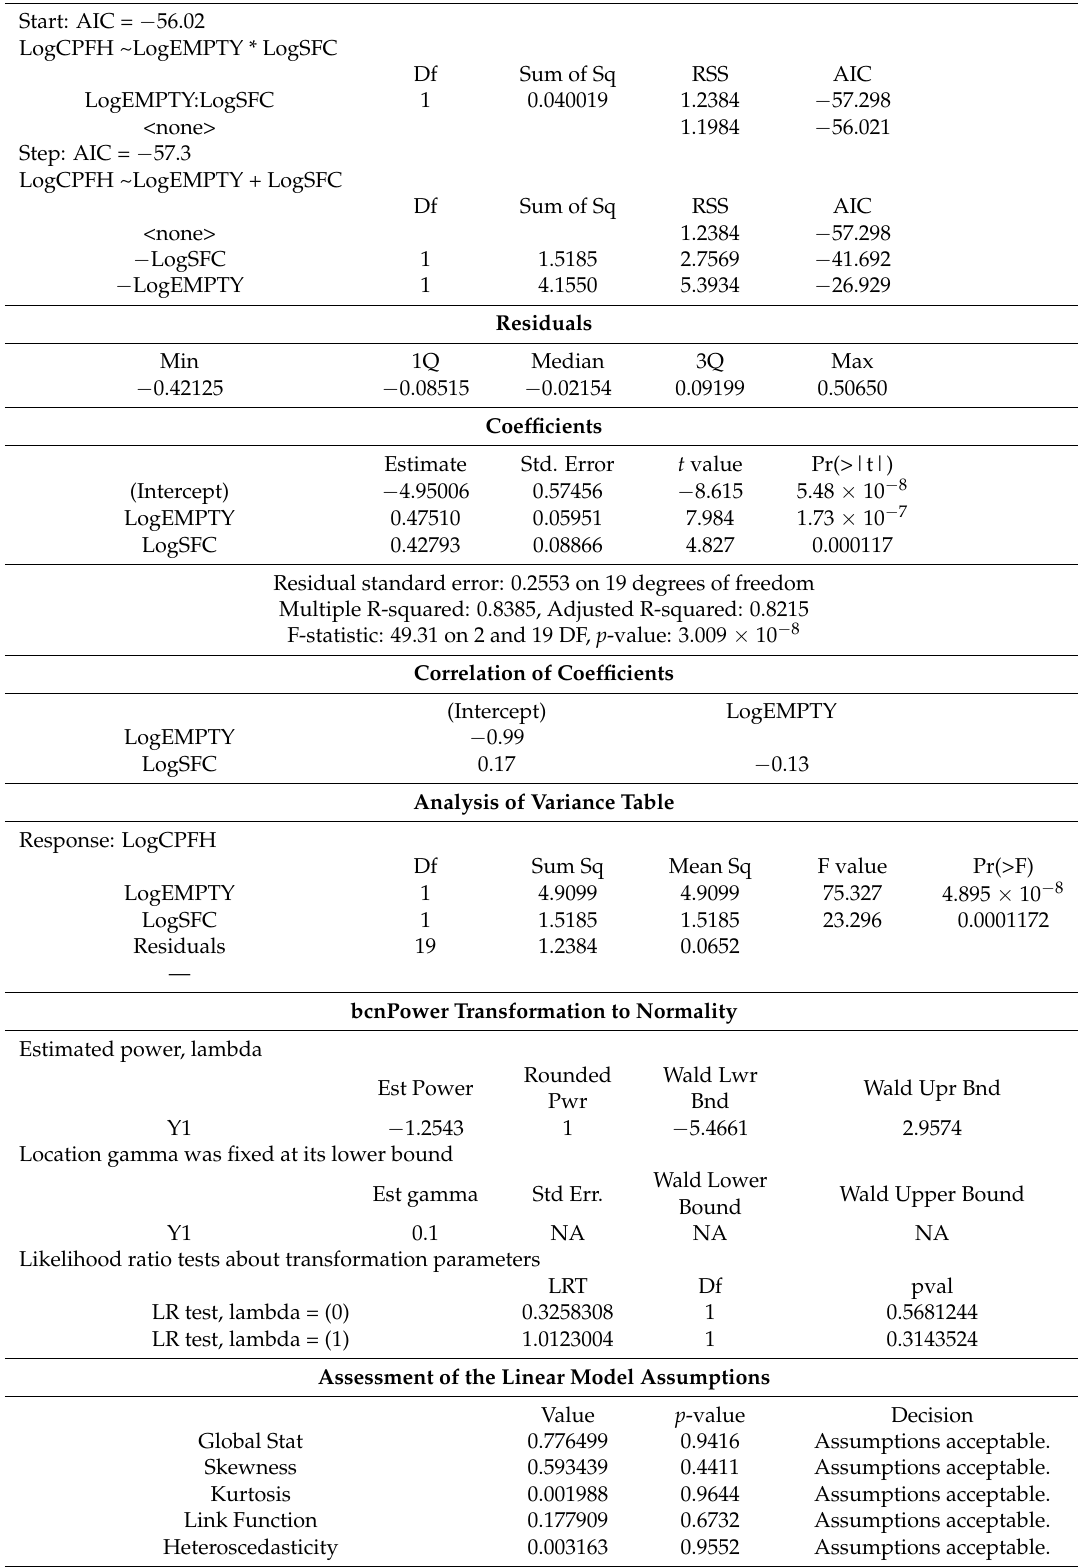
Table 4. Model summary and ANOVA. Model